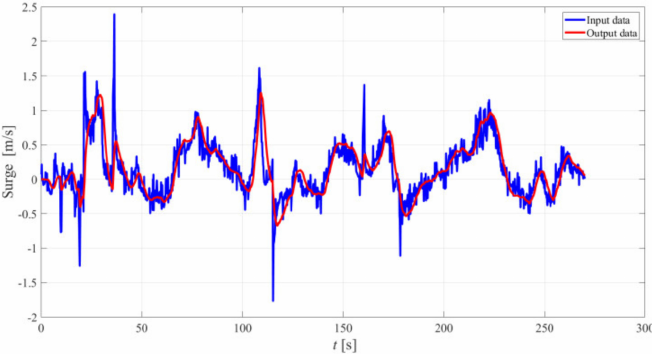
Figure 12. Surge measurement with the Kalman